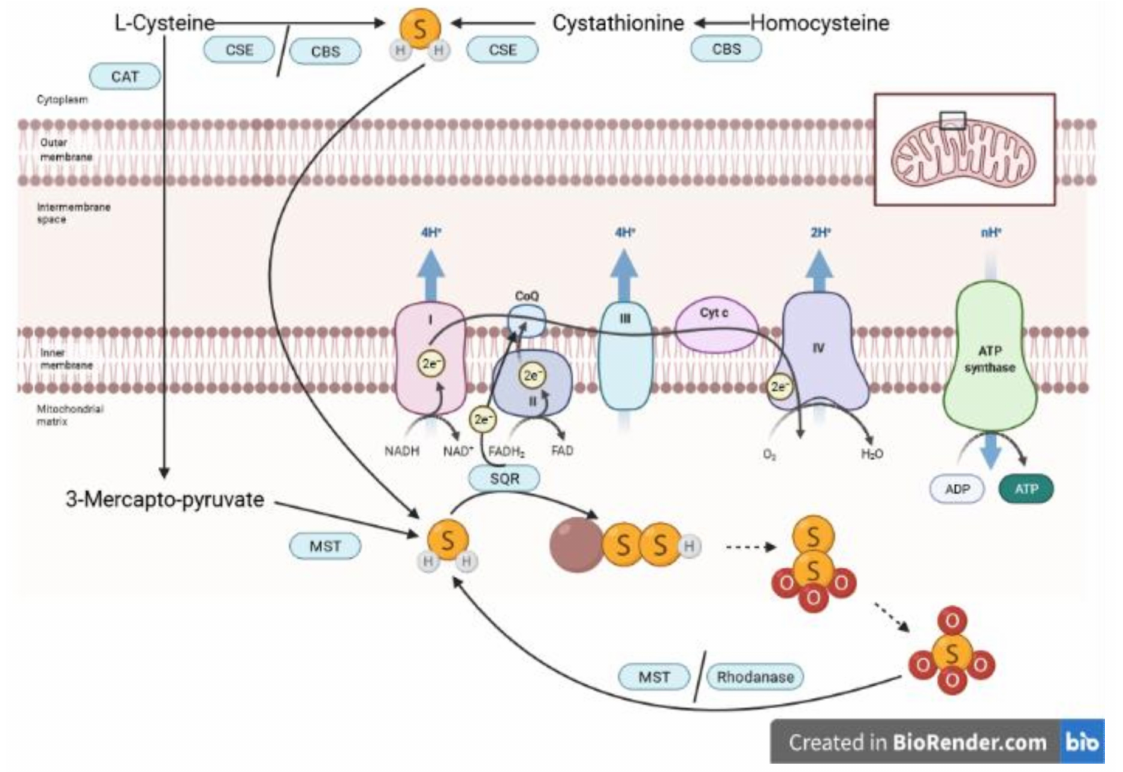
Figure 1. Sulfide generation and oxidation pathways. In the cytoplasm, cystathionine- γ -lyase (CSE) and cystathionine- β -synthase (CBS) facilitate H 2 S release from L-Cysteine and homocysteine. Cysteine-aminotransferase uses L-cysteine to form 3-mercapto-pyruvate, which is then used by 3-mercaptopyruvate-sulfurtransferase (MST) for mitochondrial H 2 S release. Sulfide quinone ox- idoreductase (SQR) oxidizes H 2 S to persulfides in the mitochondria, and persulfides are further oxidized, which ultimately results in the formation of thiosulfate and sulfate. MST and rhodanese can re-generate H 2 S from thiosulfate, a process which can also happen non-enzymatically. Figure created in BioRender. Adapted from “Electron transport chain”, by BioRender.com (2022). Retrieved from https://app.biorender.com/biorender-templates (accessed on 15 March